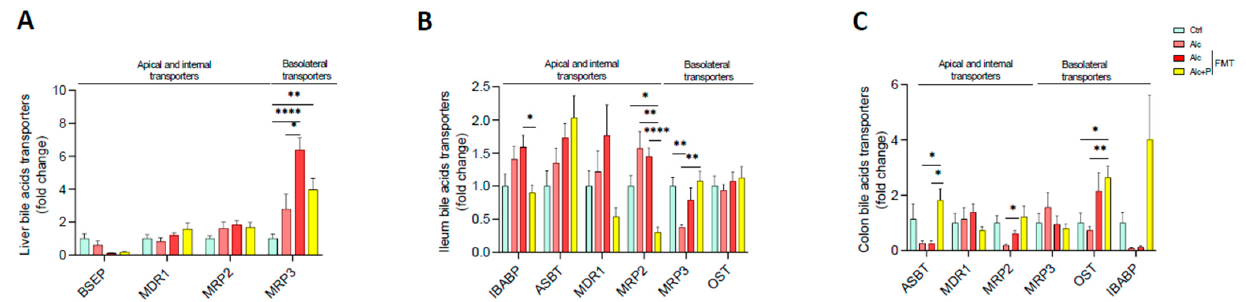
Figure 5. Alterations in bile-acid transport induced by pectin. Control (Ctrl) and alcohol-fed (Alc) mice received a Lieber DeCarli diet with isocaloric maltodextrin or alcohol, respectively. Pectin- treated mice (Alc + p ) received 6.5% pectin in addition to 5% ethanol. Human fecal microbiota transfer (FMT) groups received the microbiota of a patient with alcoholic hepatitis. Quantification of mRNA levels of BA transporters (bile salt export pump, BSEP; multidrug resistance protein 1, MDR1; multidrug resistance-associated protein 2, MRP2 and 3, MRP3; ileal bile acid binding protein, IBABP; apical sodium-dependent bile salt transporter, ASBT; organic solute and steroid transporter, OST) by qPCR in the liver ( A ), ileum ( B ), and colon ( C ). * p < 0.05, ** p < 0.01, **** p <